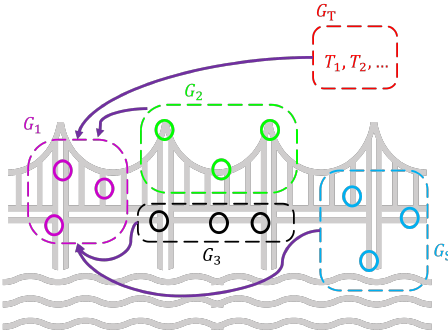
Figure 3. A model (such as a neural network) takes the temperature as the input and gives an estimation of the readings of other sensors.